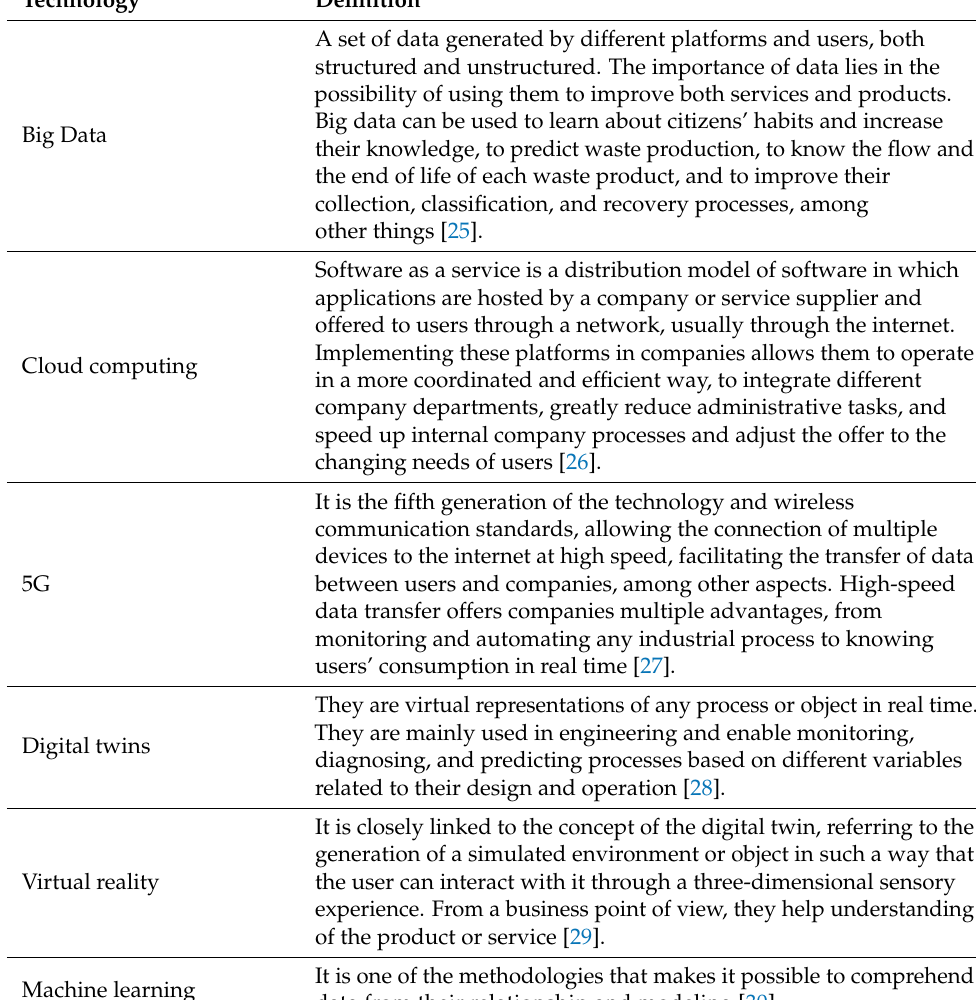
Table 1. Main digital